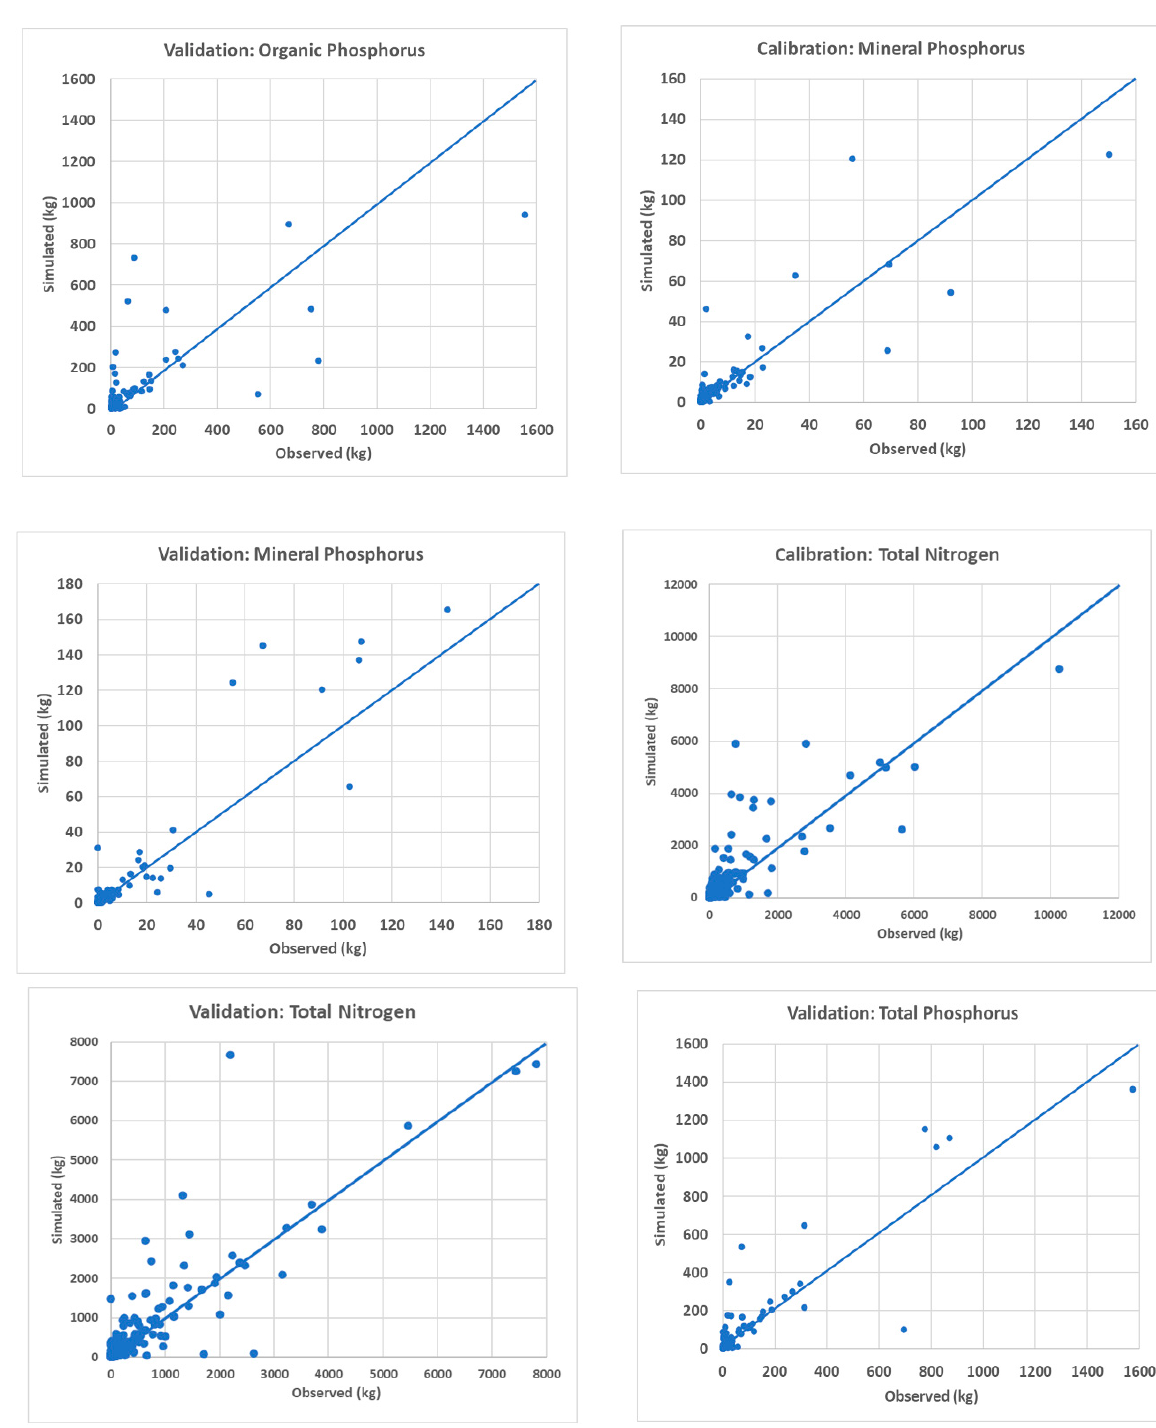
Figure A1. 1:1-line Plots for Calibration and Validation results for the observed and simulated variables.